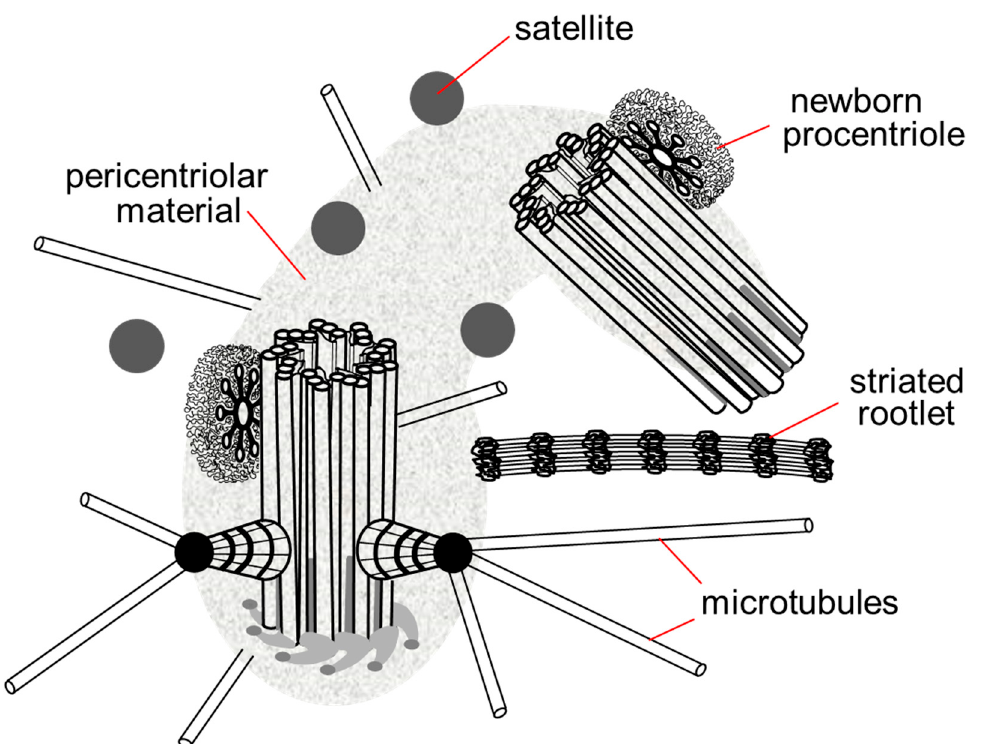
Figure 3. Centrosome in the late G1 phase of the cell cycle. The pericentriolar material completely surrounds the mother centriole and the proximal end of the daughter centriole, the satellites are located around the centrosome, in contact with the pericentriolar material, the striated rootlet is not an obligatory component of the centrosome in non-ciliary cells, its functions are not known.